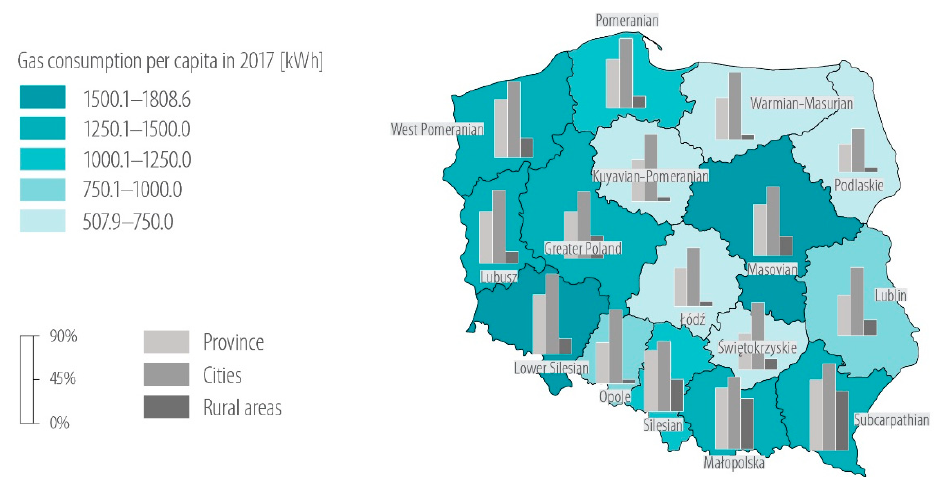
Figure 4. Population using gas from the network and gas consumption per capita in 2017 (based on Reference [25]).